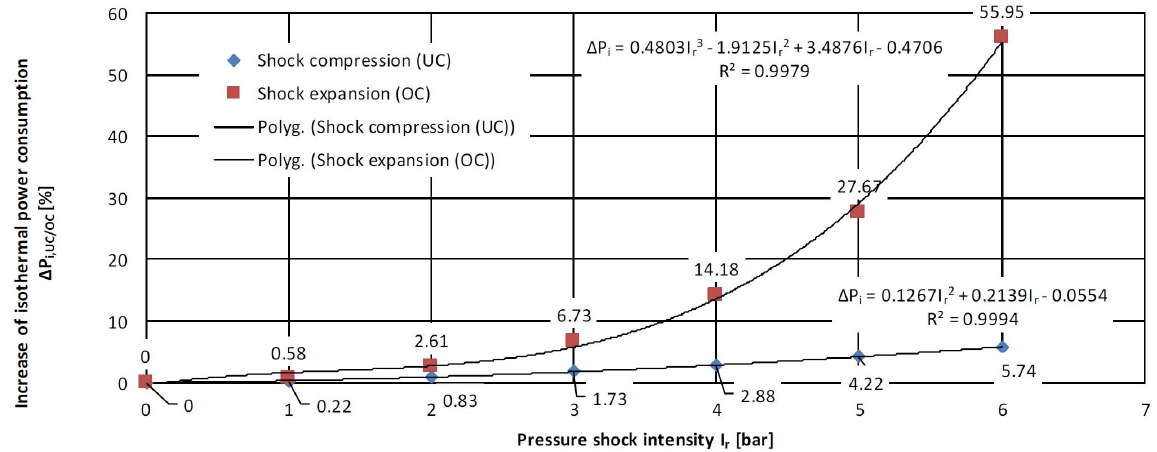
Figure 5: Diagram of increase (change) of instantaneous isothermal power consumption needed for compression in dependence of shock compression (UC) and shock expansion (OC)